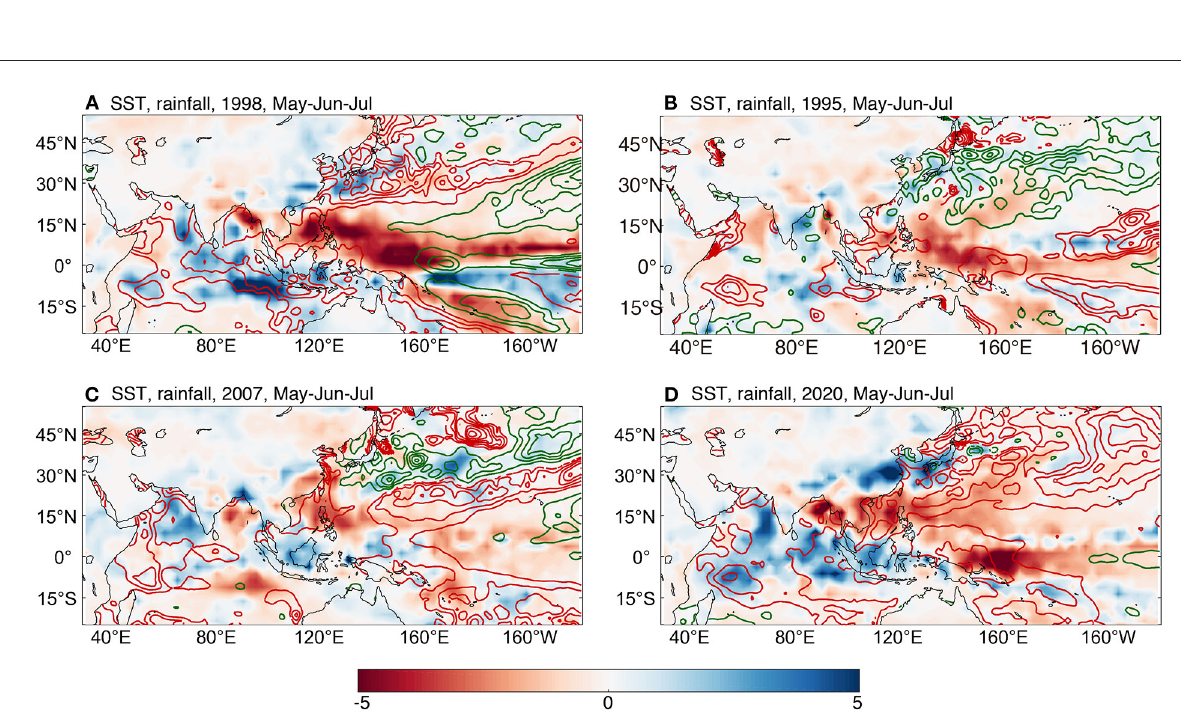
FrontiersinClimate